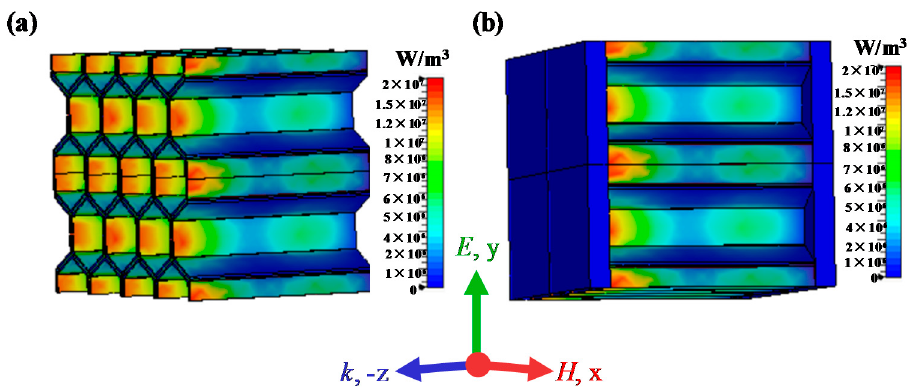
10. The interface between the upper panel and honeycomb exhibits a strong electromag-